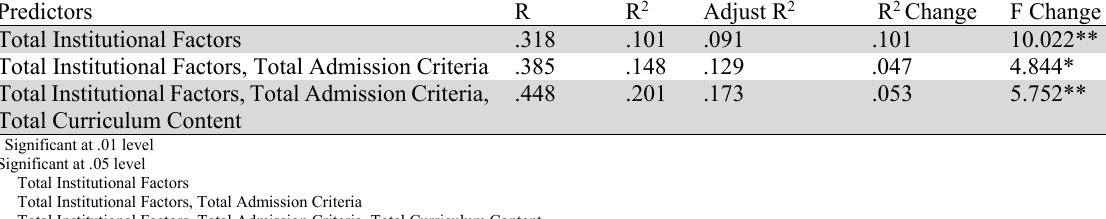
The results of multiple regression estimate Predictors